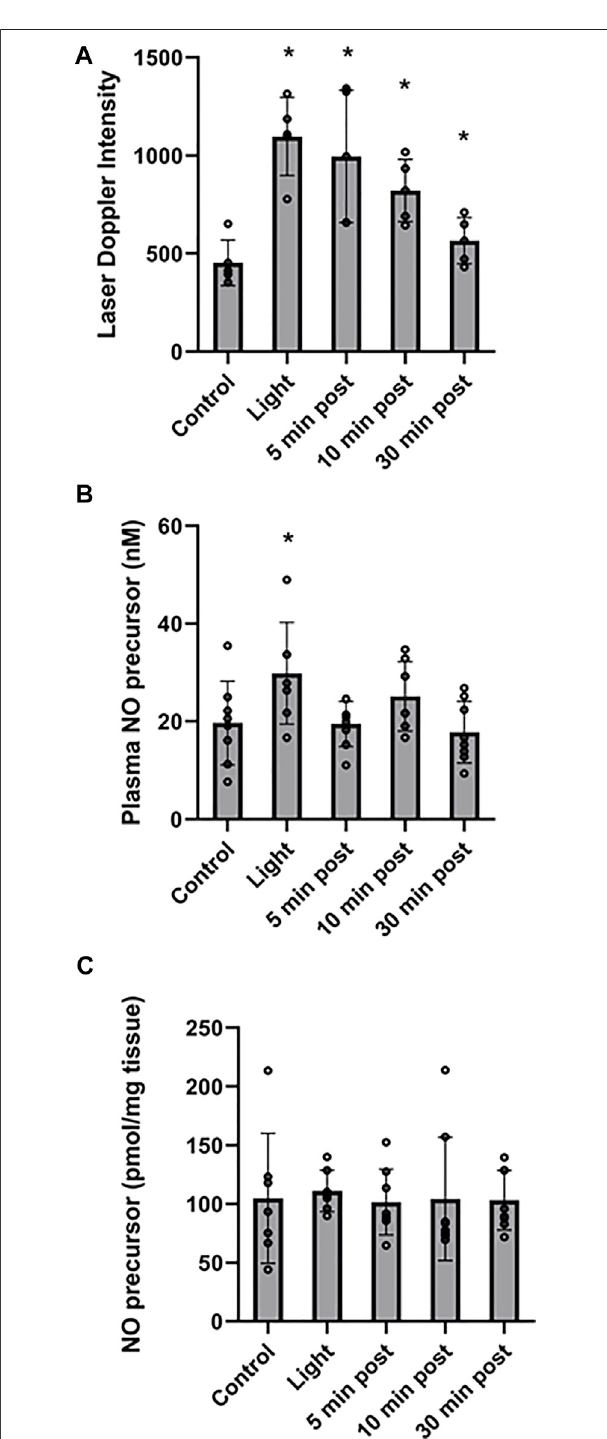
FIGURE 3 | Stability of red light-dependent vasodilator. 670 nm light was applied at 50 mW/cm 2 for 10 min on entire body of C57BI/6 mice with and the vasodilation was assessed at 0, 5, 10, and 30 min after fi nishing the irradiation. (A) :Blood fl owmeasuredwithLaserDopplerImaging. (B,C) : The NO-derived vasodilator was measured with ozone-based chemiluminescenceinplasma (B) ,andrightquadricepstissue (C)